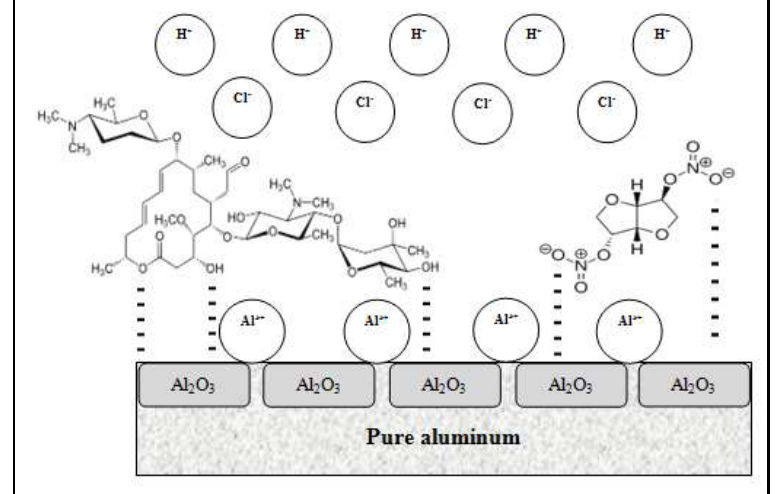
Figure 10: Mechanism of corrosion inhibition by